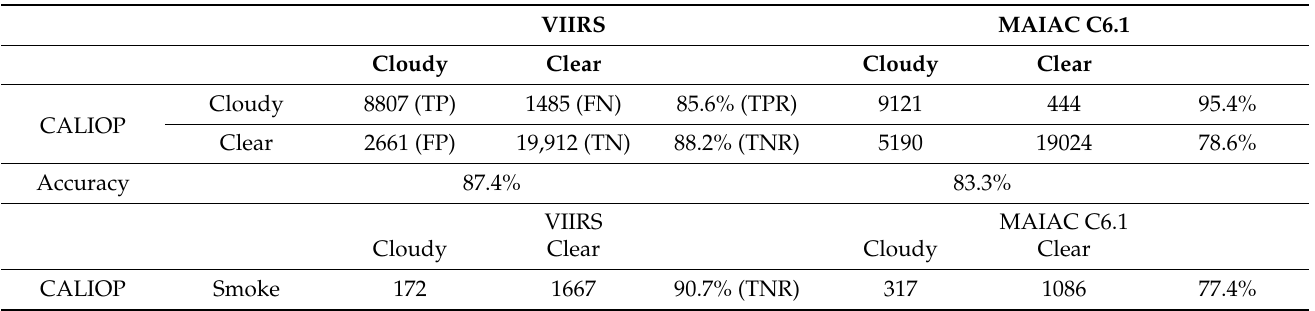
Table 3. Confusion matrix for the comparison of pixels from each cloud mask associated with the two AOD products against collocated information from the CALIOP cloud layer data. The abbreviations in parentheses denote (for both sets of data): true positive (TP), false positive (FP), true negative (TN), false negative (FN), true positive rate (TPR), and true negative rate